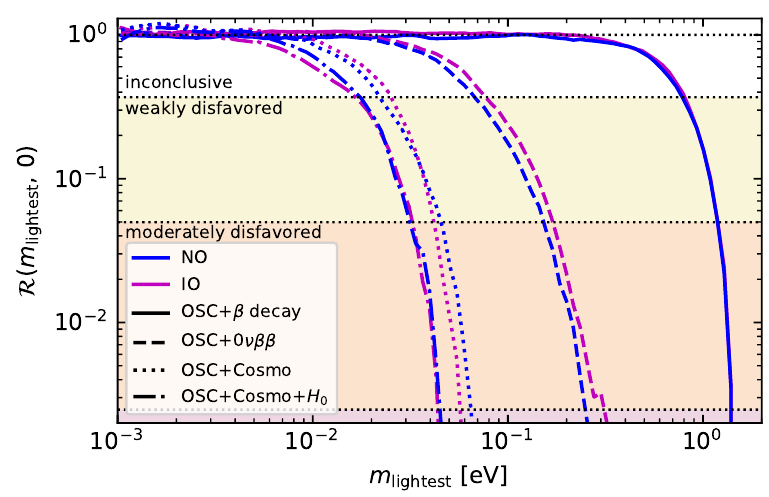
Figure 11 . Prior-independent [124] constraints on the lightest neutrino mass from different data combinations, for normal (blue) and inverted (magenta) neutrino mass